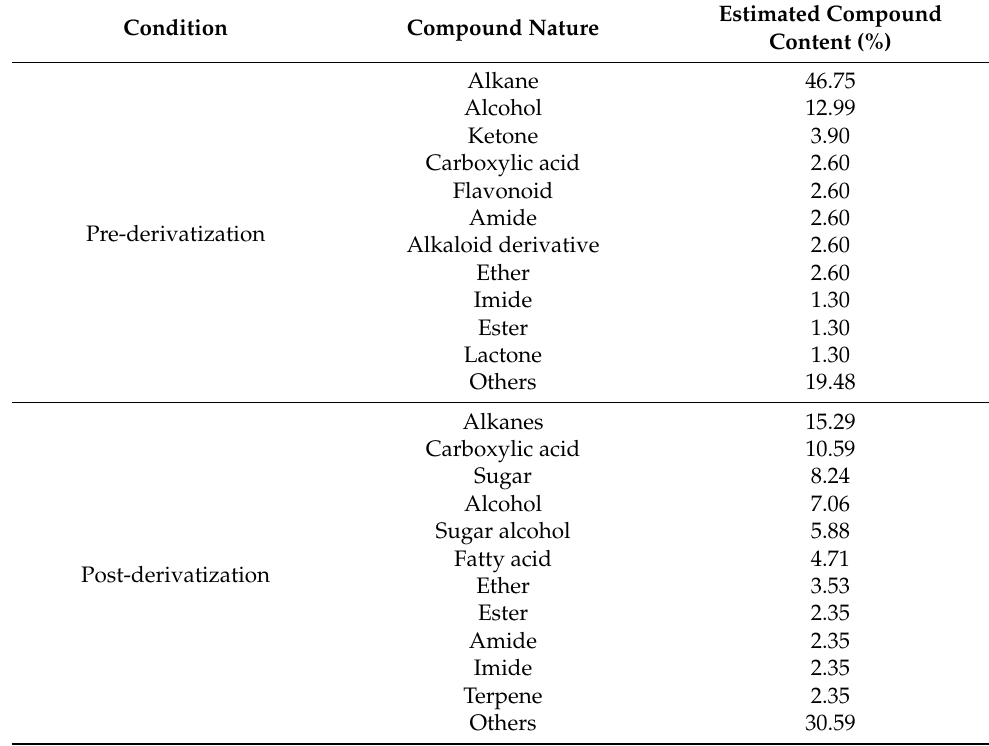
Table 4. Major classes of compounds detected by GC-MS before and after